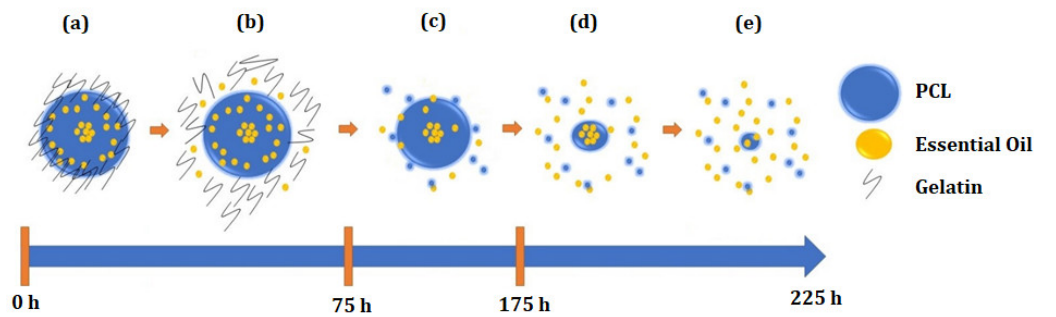
Figure 10. Schematic diagram of the speculative proposal for the interpretation of the controlled release associated with particle design as a function of time: ( a ) particle consisting mainly of gelatin, PCL, and essential oil, ( b ) hydration/solubilization process of the gelatin layer, allowing the release of some amount of essential oil, ( c ) starting of the degradation of PCL, ( d , e ) increasing of the released essential oil.